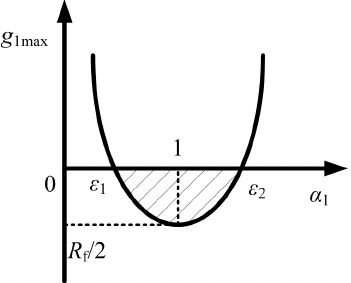
Figure 6. The relationship between α 1 and g 1max .